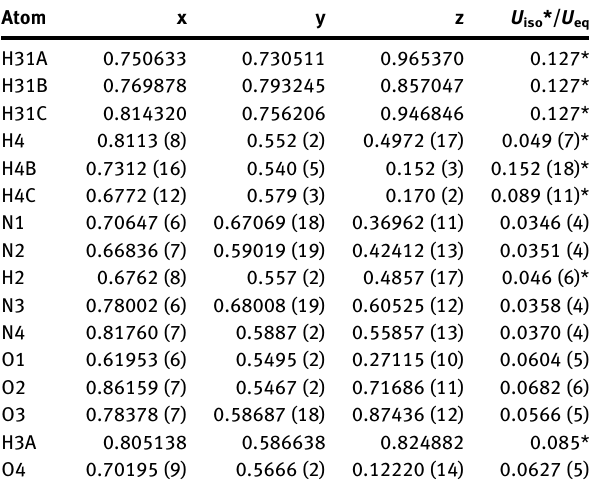
Table  : Fractional atomic coordinates and isotropic or equivalent isotropic displacement parameters (Å 